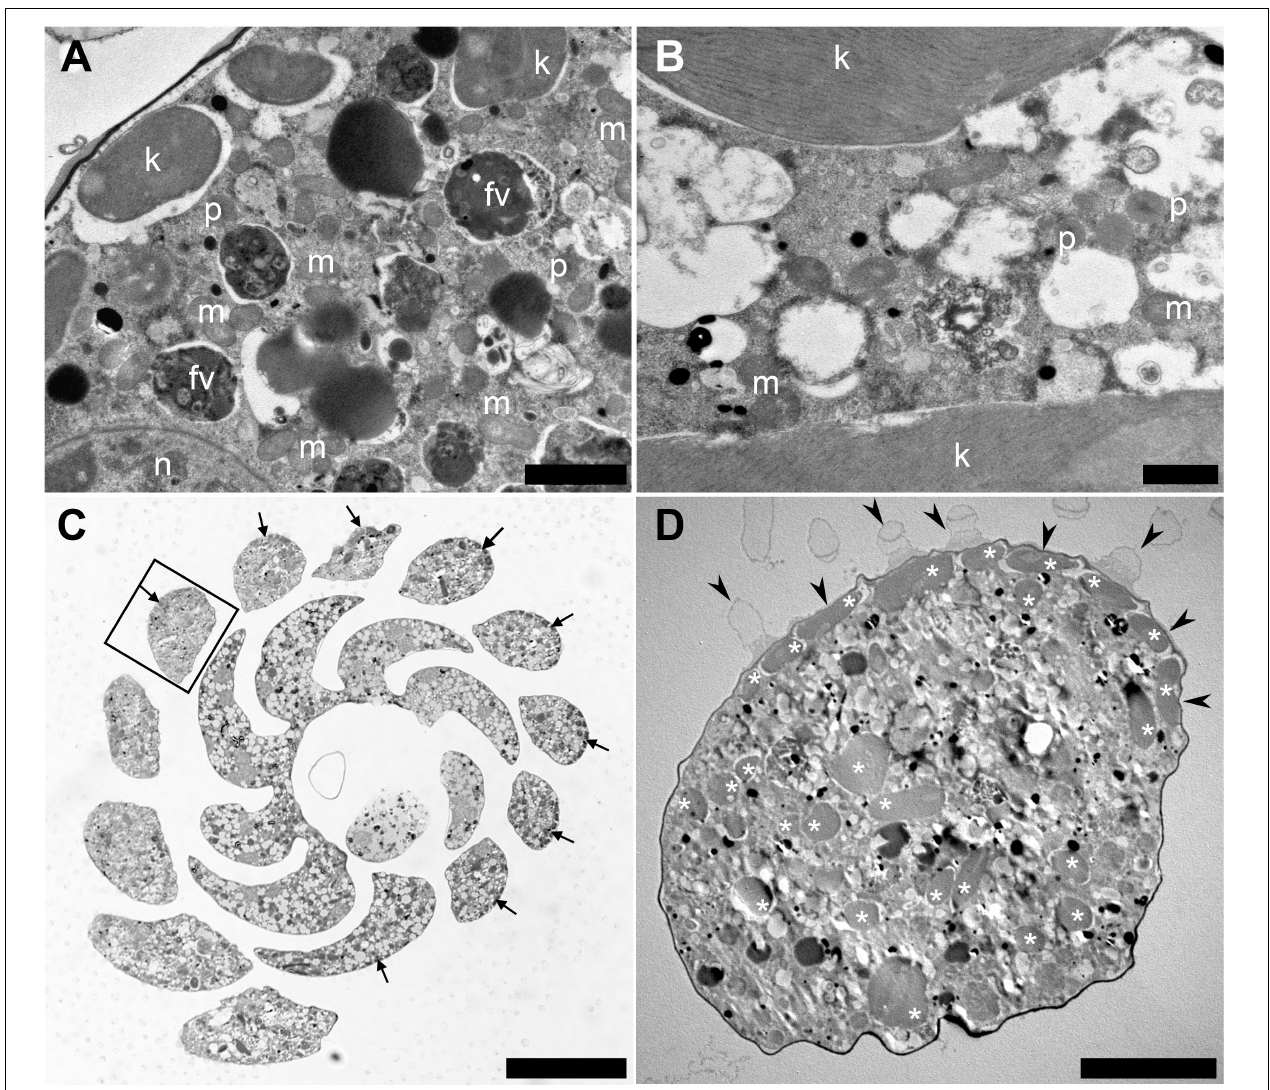
FIGURE 1 | Transmission electron micrographs of Planoglabratella opercularis . Images were taken from horizontal sections. (A) Kleptoplasts (k), food vacuoles (fv), mitochondria (m), peroxisomes (p), and nucleus (n) are visible. Scale bar = 2 µ m. (B) Dense mitochondria (m) and peroxisomes (p) are found in interstitial spaces between kleptoplasts. Scale bar = 1 µ m. (C) Optical micrographs of horizontal sections. Scale bar = 50 µ m. Flattened kleptoplasts are distributed along the chamber (cell periphery) (arrows). (D) Higher magnification of a chamber in the square of figure (C) . Kleptoplasts (*) located just beneath the pore plug (arrowheads). Scale bar = 10 µ